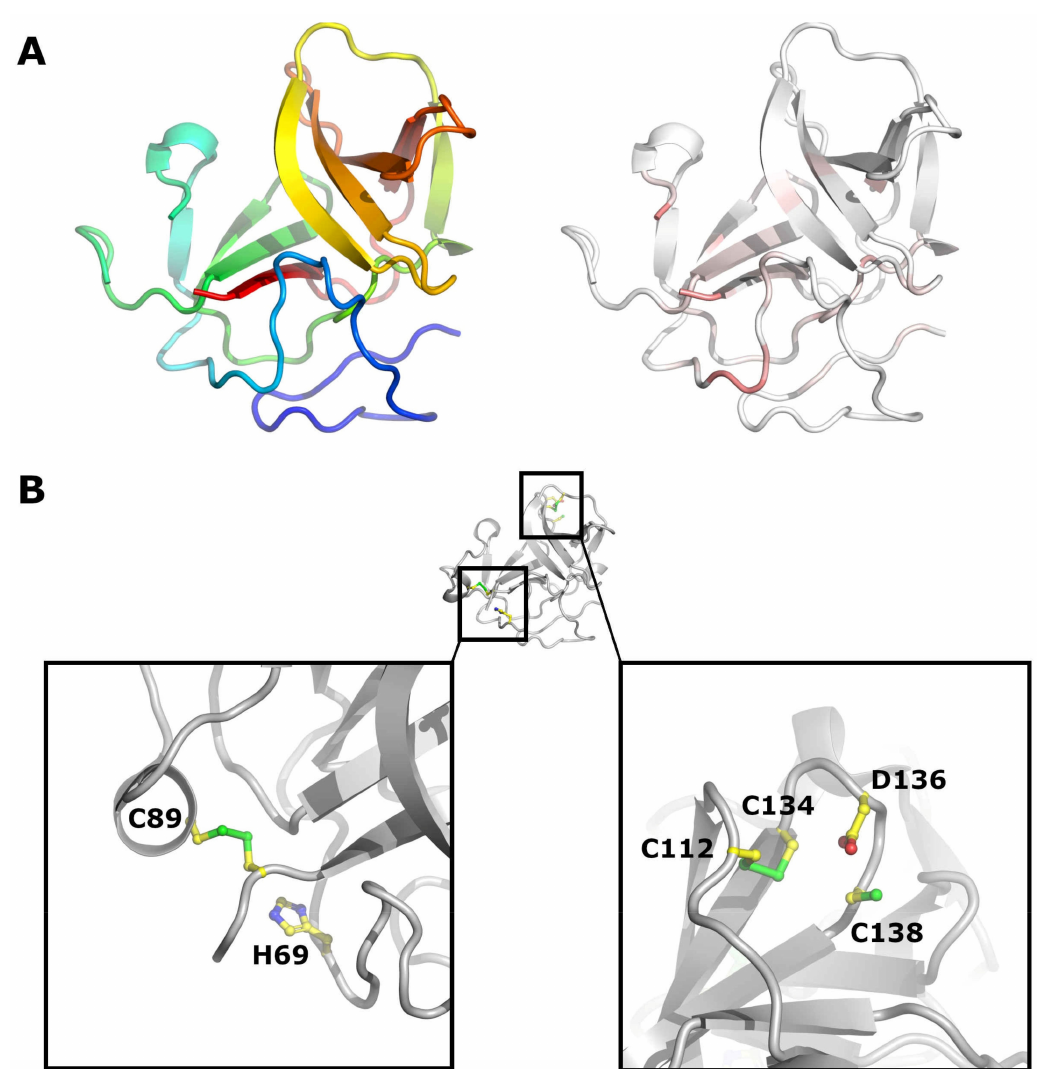
Figure 4. Crystal structure of CSFV Npro. ( A ) Cartoon representation of Npro (PDB code 4H9J). On the left, Npro is coloured from the N terminus (blue) to the C terminus (red). On the right, Npro is coloured according to sequence conservation from white (non-conserved) to red (conserved). ( B ) Location of important residues in Npro, H69 and C89 (left, APPV numbering) and the TRASH motif (right) are drawn as sticks. Figures 4–8 were prepared with PyMOL (The PyMOL Molecular Graphics System, Schrödinger, LLC., New York, NY,